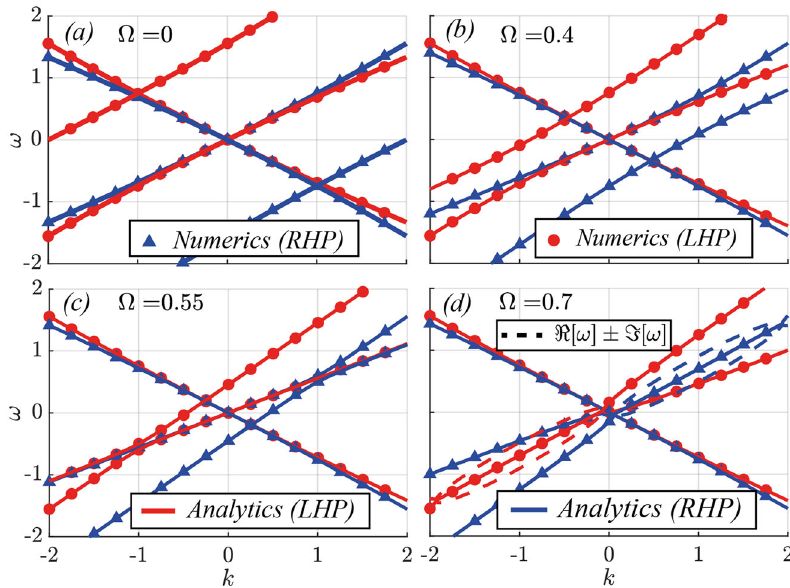
Fig. 2 Band structure of the photonic Archimedes ’ Screw for the zero-dephasing ( ϕ = 0) and α ε = α μ = α = 0.4 (impedance-matched) case, for g = 1 (so that v s = Ω ). The different panels correspond to increasing modulation frequency/speed ( a ) Ω = 0, ( b ), Ω = 0.4, ( c ) Ω = 0.55 and ( d ) Ω = 0.7. Note (cid:4) 0 : 5556, this interaction gives rise to the PT-broken phase, with complex RHP bands (the the attraction ( c ) between forward RHP bands: as Ω ! Ω (cid:2) crit dashed lines show the two complex states ℜ [ ω ] ± ℑ [ ω ]) being shown for Ω = 0.7 in ( d ).